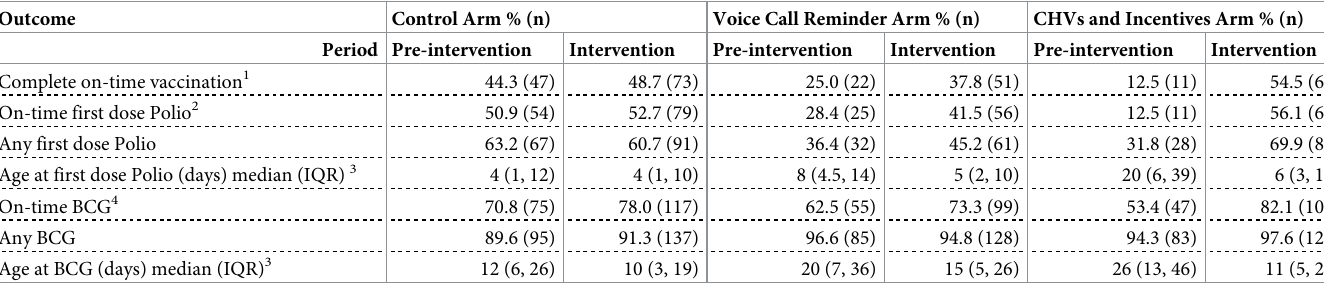
Table 2. Birth dose vaccination coverage in GEVaP study [descriptive] (N = 690). Outcome Control Arm %